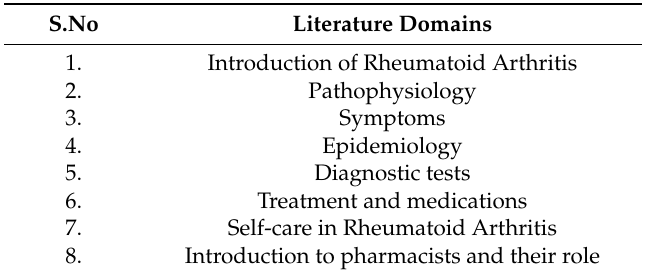
Table 2. Educational domains with the order of arrangement in